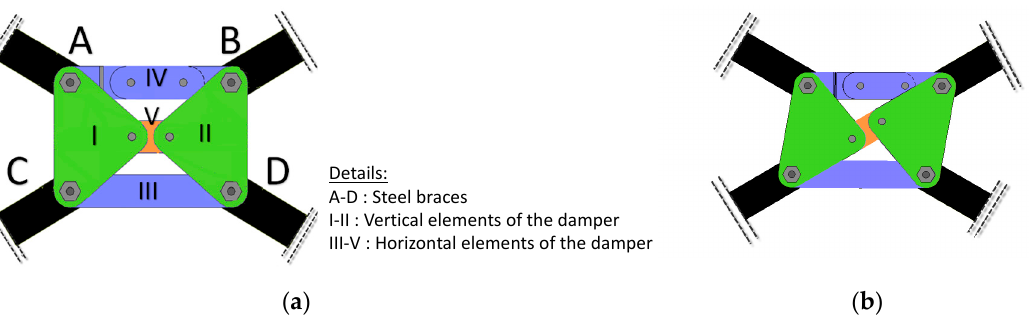
Figure 6. Construction of the improved Pall friction damper proposed by Papadopoulos, ( a ) inactive damper, ( b ) activation of the damper.